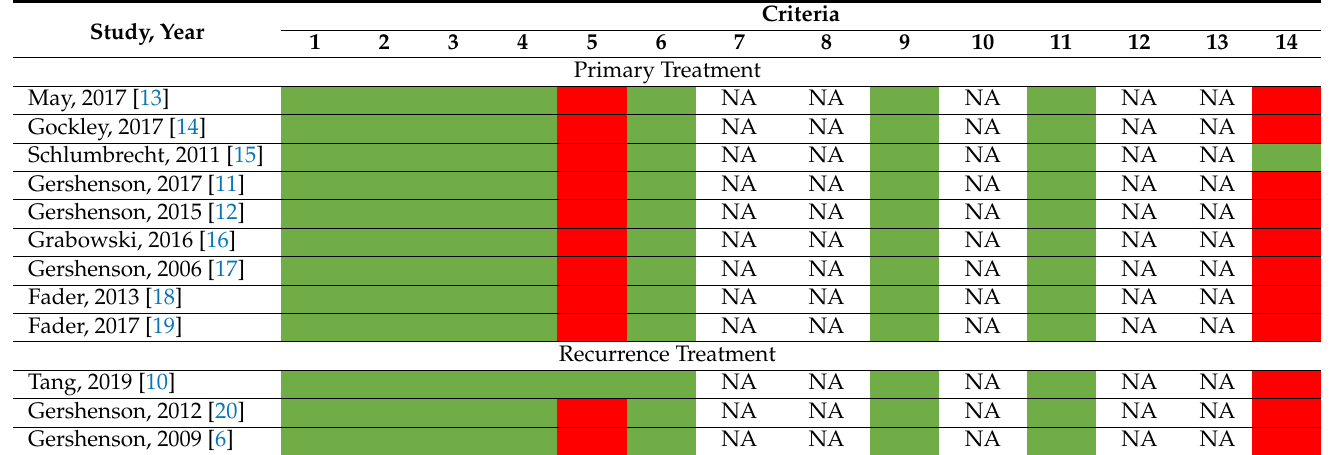
Table 4. Quality assessment of the 12 included